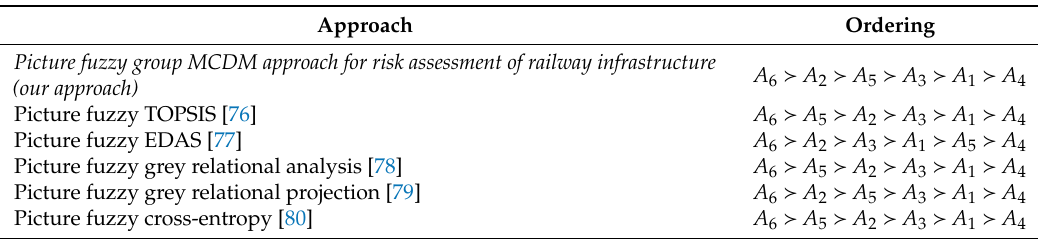
Table 12. The comparative analysis of the state-of-the-art picture fuzzy